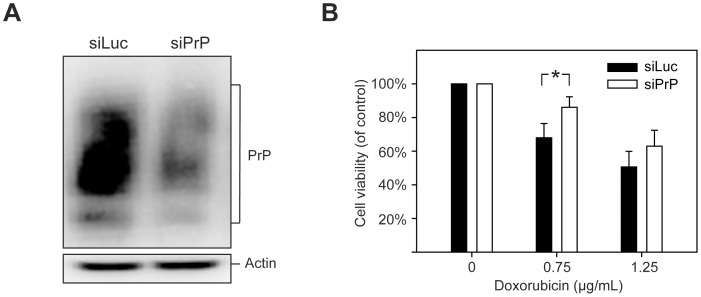
The influence of transient PrP knockdown on doxorubicin induced cytotoxicity in MDA-MB-435 cells.(A) Immunoblot analysis of PrP in MDA-MB-435 cells 24 hours after transient transfection with pSIREN-RetroQ-siLuc (siLuc) or pSIREN-RetroQ-siPrP (siPrP) plasmid. (B) Twenty-four hours after transient transfection with pSIREN-RetroQ-siLuc (siLuc) or pSIREN-RetroQ-siPrP (siPrP) plasmid, cells were incubated with doxorubicin for 48 hours at indicated concentrations. Cell viability was measured by the MTT assay. Asterisks represent statistically significant differences, which were determined by student's t test and indicated by * P<0.05.